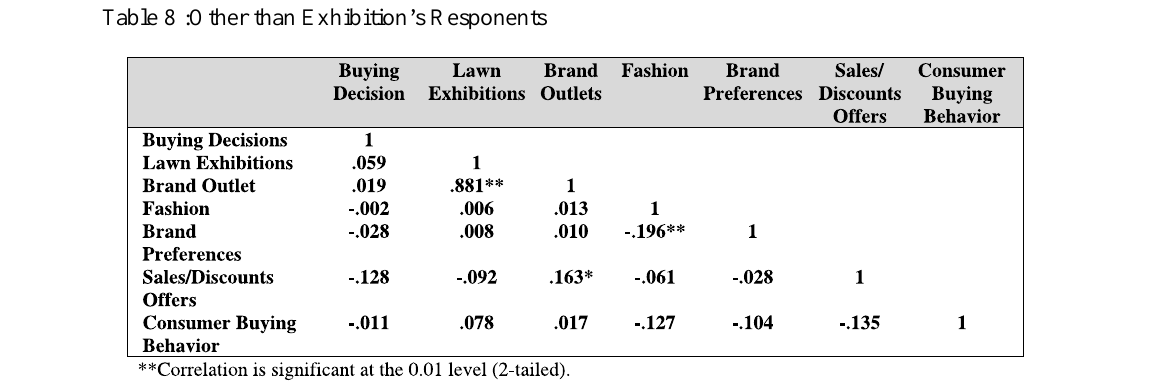
Table 8 :Other than Exhibition’s